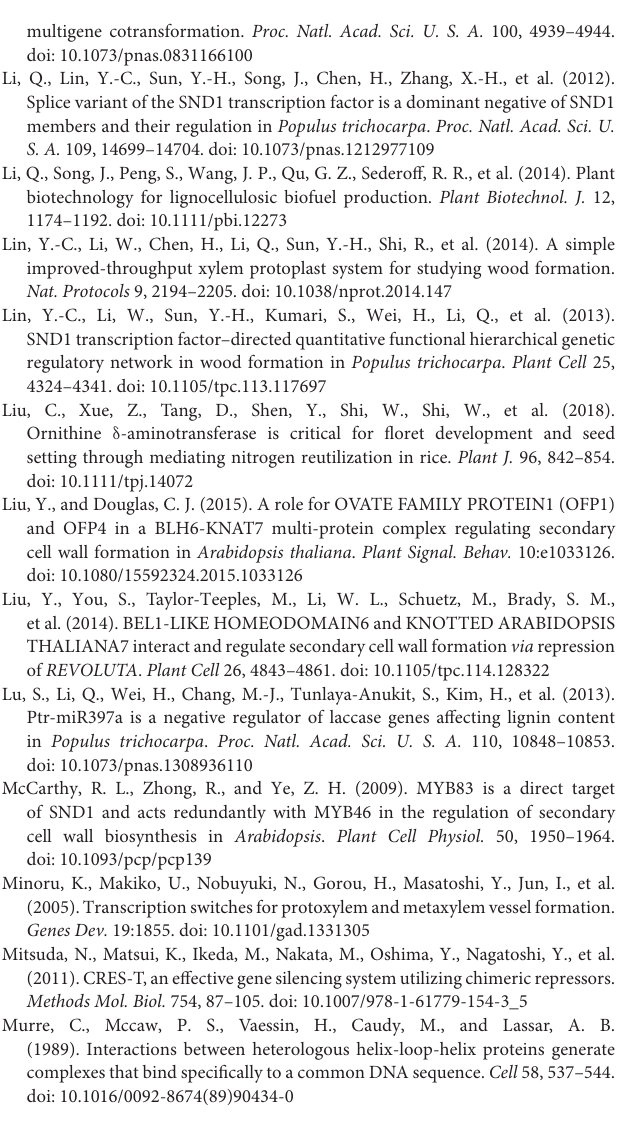
Supplementary Figure 2 | Expression patterns of 12 TFs and two CAld5H genes in stem cryosections of P. tremula . Supplementary Figure 3 | Protein – protein interactions among 12 TFs by LCI assays. Supplementary Figure 4 | qRT-PCR of transgene BLH6a:SRDX in the leaves of 36 transgenic lines. Supplementary Table 1 | Primers used in this study. Supplementary Table 2 | 12 TF candidates regulating CAld5H2 . Supplementary Table 3 | Summary of interactions among 12